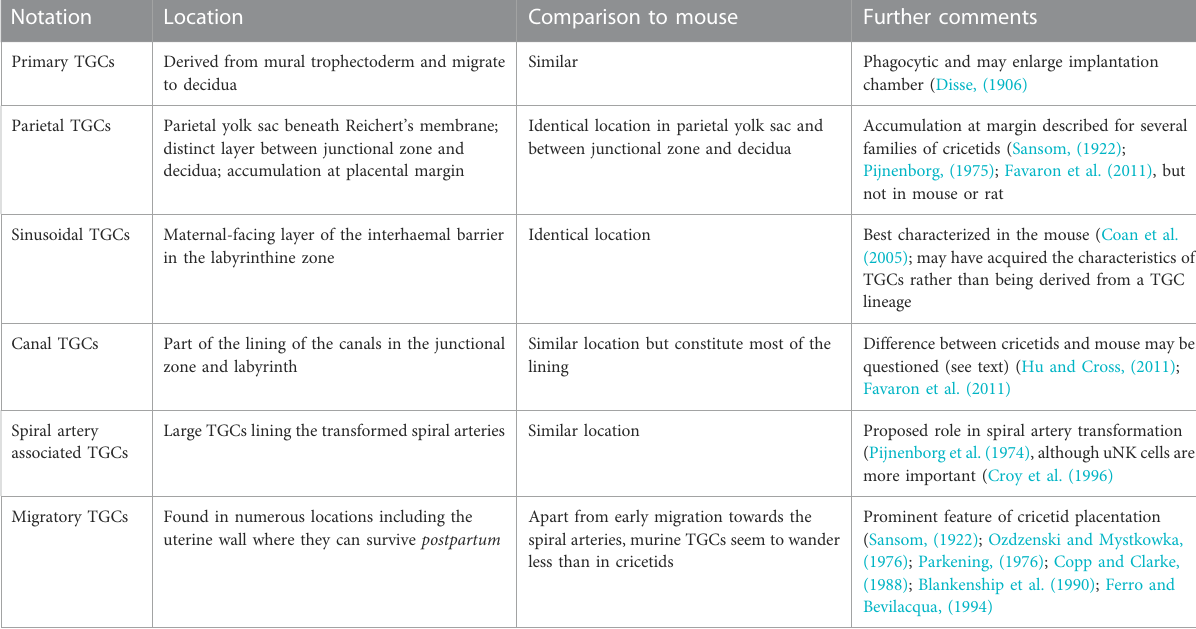
TABLE 2 Provisional notation for trophoblast giant cells (TGCs) of cricetid rodents with comparison to the mouse for which transcriptional data is also